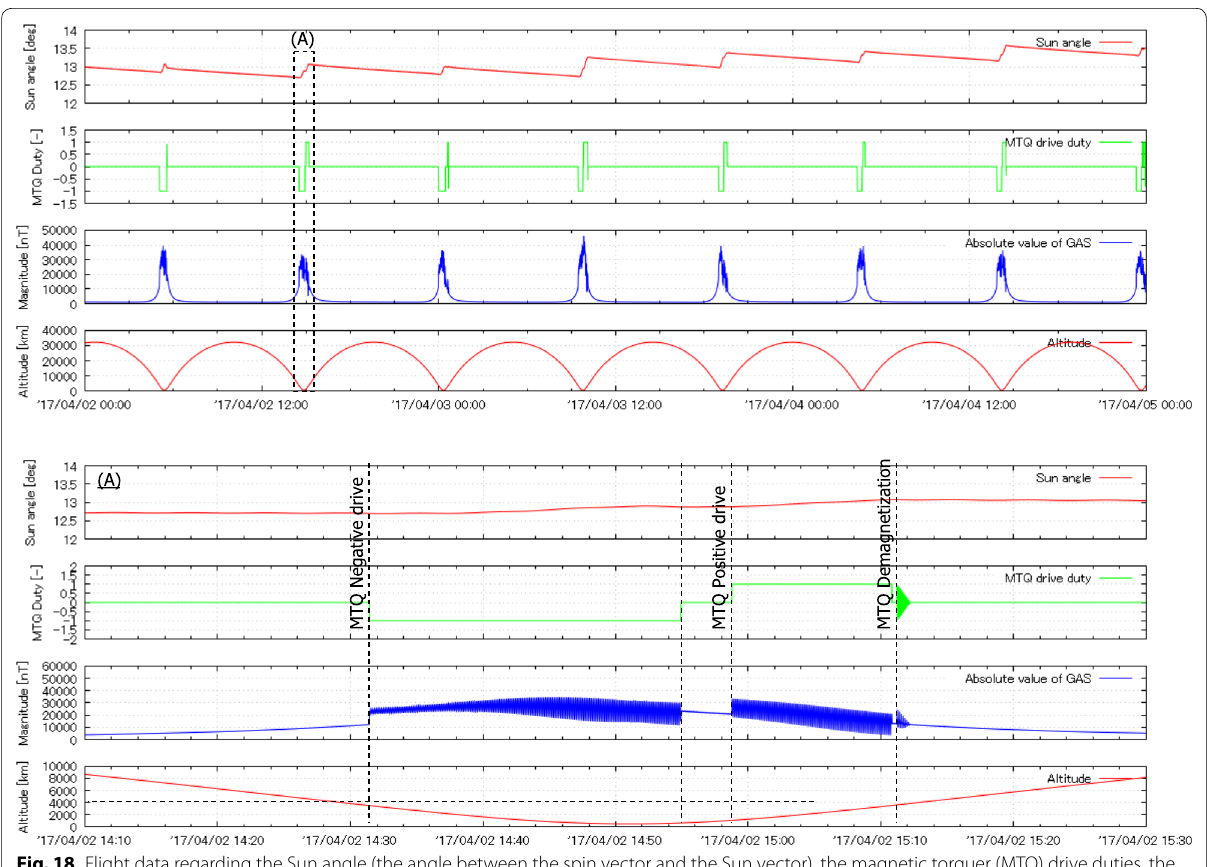
Fig. 18 Flight data regarding the Sun angle (the angle between the spin vector and the Sun vector), the magnetic torquer (MTQ) drive duties, the geomagnetic aspect sensor (GAS), and the satellite